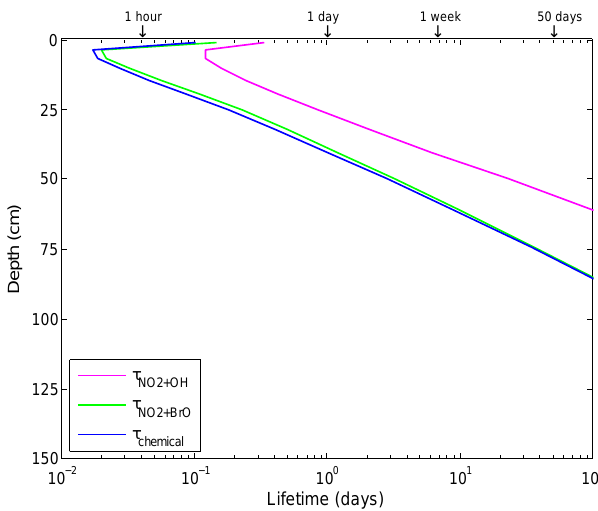
Fig. 4. Depth-dependent lifetime (days) of NO x in the snowpack against chemical conversion to HNO 3 ( τ NO , pink curve), 2 + OH BrONO 2 ( τ NO , green curve), and the combination of the two 2 + BrO reactions ( τ chemical , blue curve) for near station snow at Summit. The lifetime curves are calculated using concentration profiles of BrO, OH, NO, and NO 2 from Thomas et al.